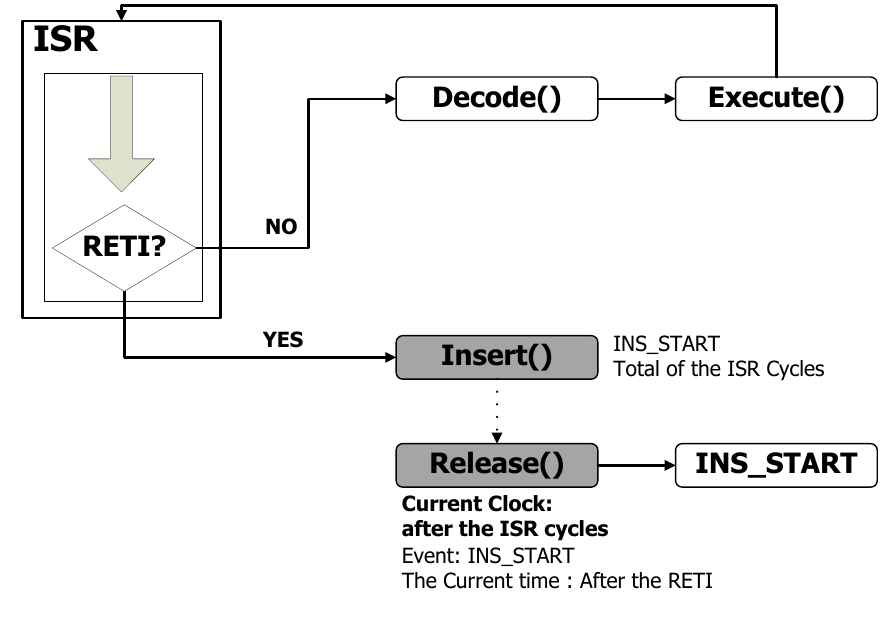
Figure 5. Optimistic asynchronous simulation of ISR without accessing the event